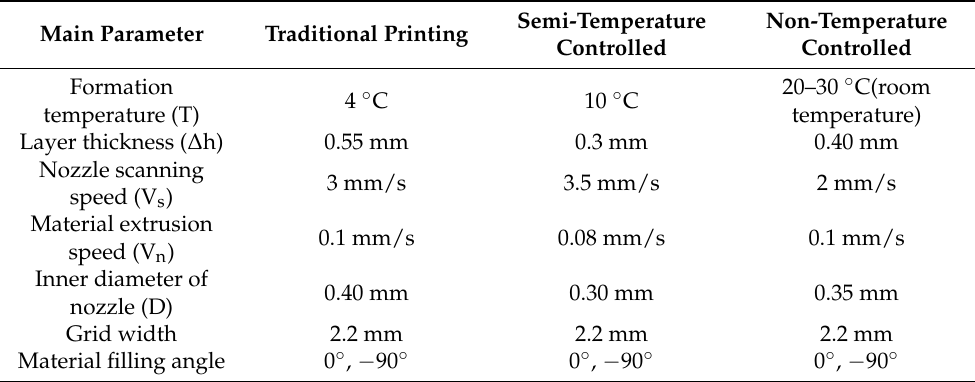
Table 1. Main parameters of three printing